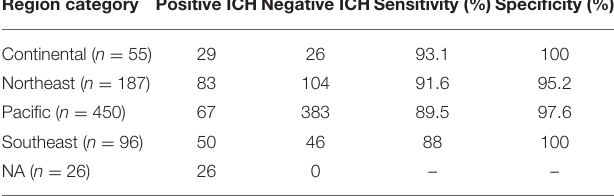
TABLE 3 | Performance metrics for ICH cases by geographic distribution in the United States.